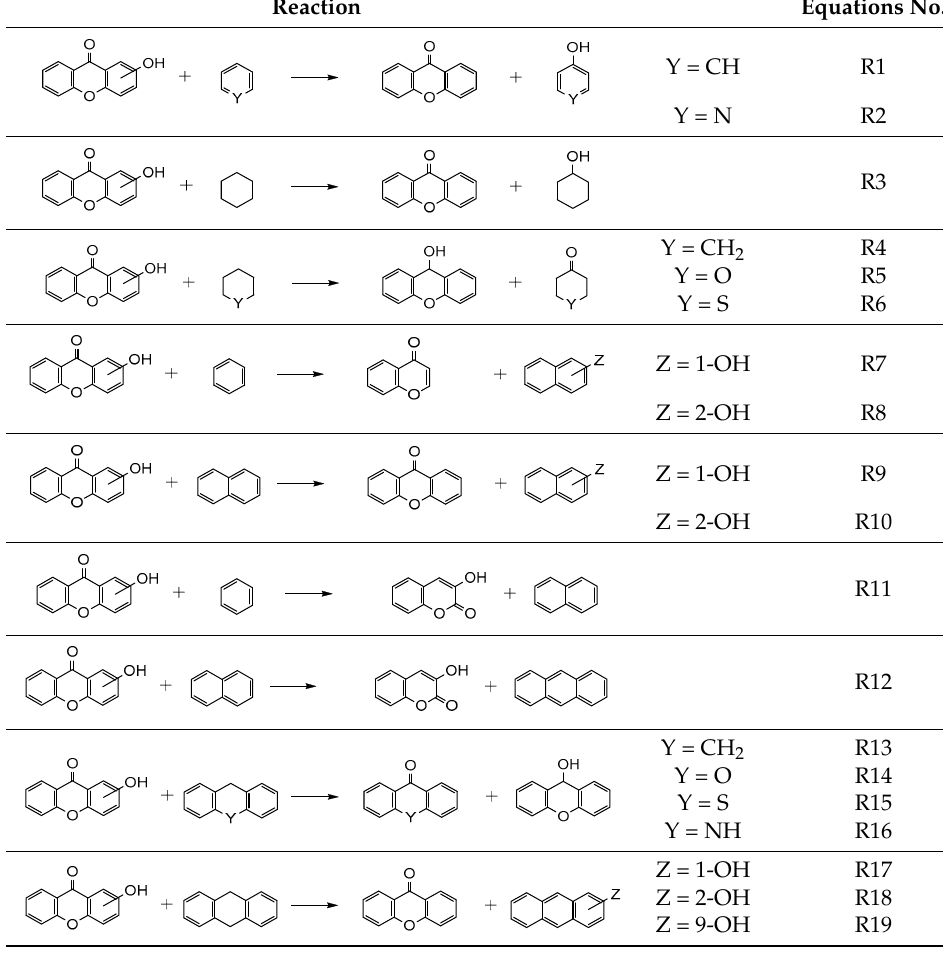
Table 4. Hypothetical gas-phase reactions for the theoretical study of monohydroxyxanthones. Reaction